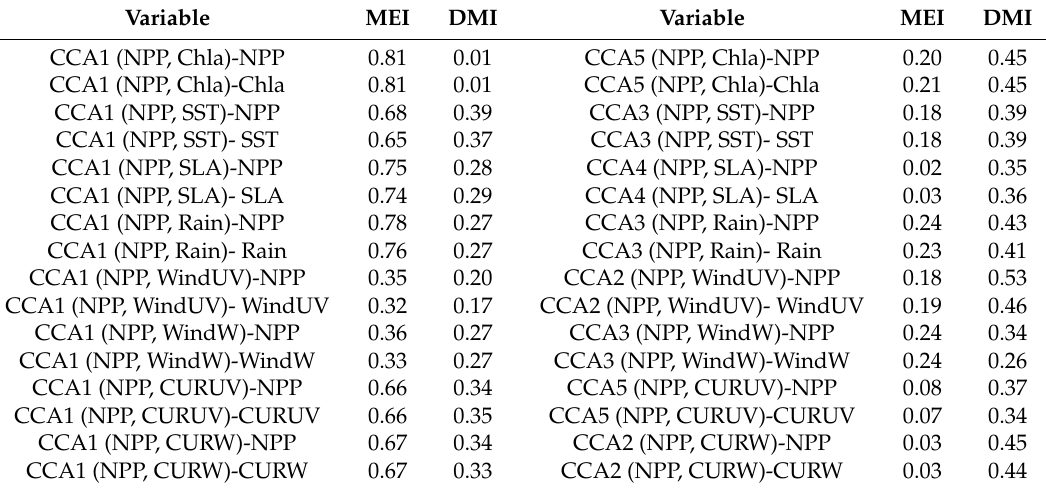
Table 4. Canonical time series correlation coefficients of biophysical variables with climate-related indices of MEI and